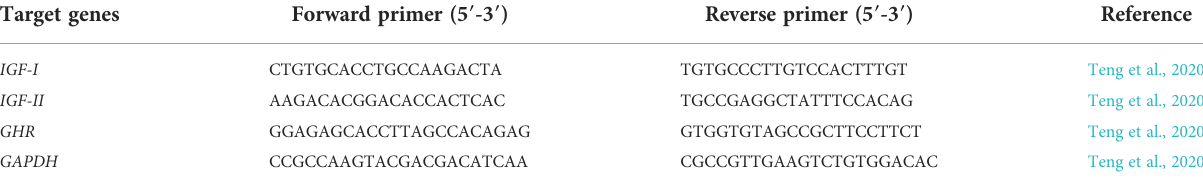
TABLE 2 Sequence of the primers used for real -time PCR of growth-related genes. Target